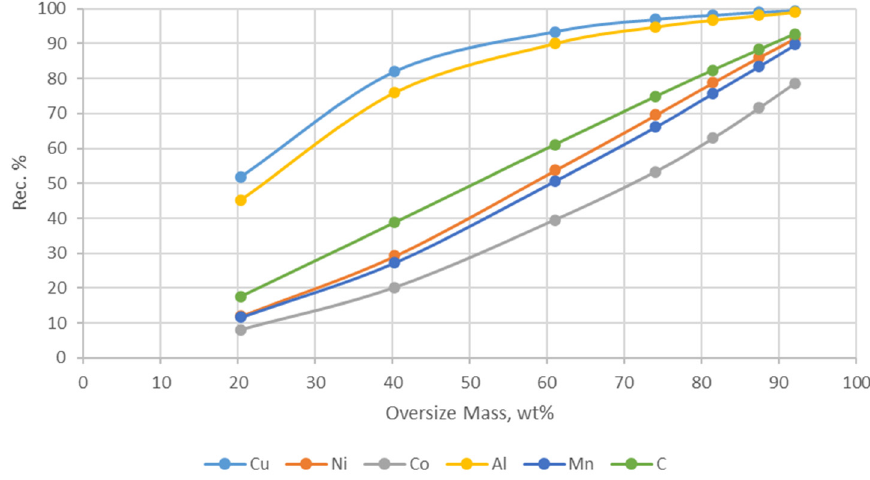
Figure 3. Recoveries of Cu, Ni, Co, Al, Mn, and C in the oversize fractions vs. mass